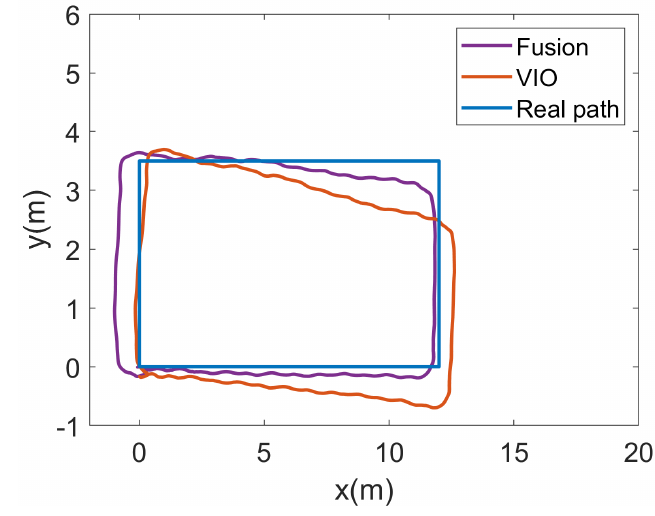
Figure 13. Moving trajectory of the conference room.